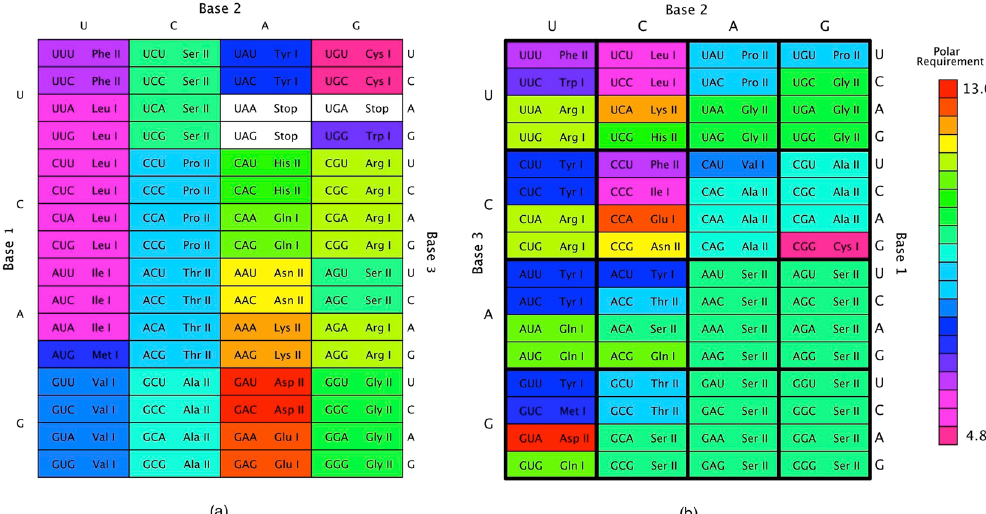
Figure 1. Assignments of the 64 codons of the genetic code. The bases of the codon table are arranged according to their specific error robustness: least (top), middle (left), and most robust (right). An amino acid’s slot is coloured according to its polar requirement to illustrate chemical similarity. Its aminoacyl-tRNA synthetase class is I or II. ( a ) The highly ordered standard genetic code. Stop codon slots are coloured white. ( b ) A highly robust artificial code emerging from the iterated learning model. Stop codons were not included in the